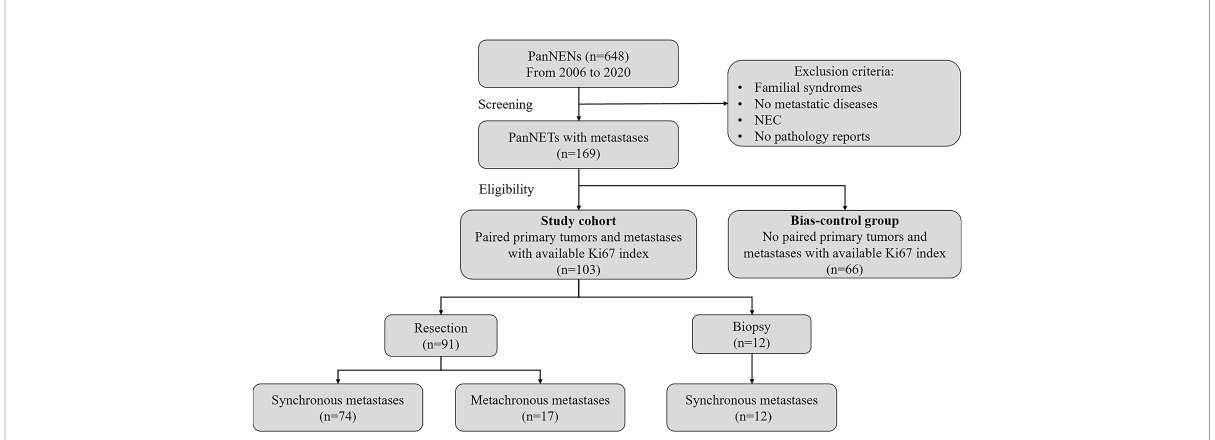
FIGURE 1 Flow diagram of the study cohort. Out of the 648 patients with PanNENs, 169 patients with metastatic PanNETs were included for further eligibility evaluation. Then 103 patients had paired primary tumors and metastases with an available Ki67 index were identi fi ed as the study cohort, and the remaining 66 patients were identi fi ed as the bias-control group. The study cohort consisted of 91 patients underwent resection and 12 patients experienced biopsy. In resection cohort, 74 and 17 patients had synchronous and metachronous metastases, respectively. And biopsy cohort consisted of 12 patients with synchronous